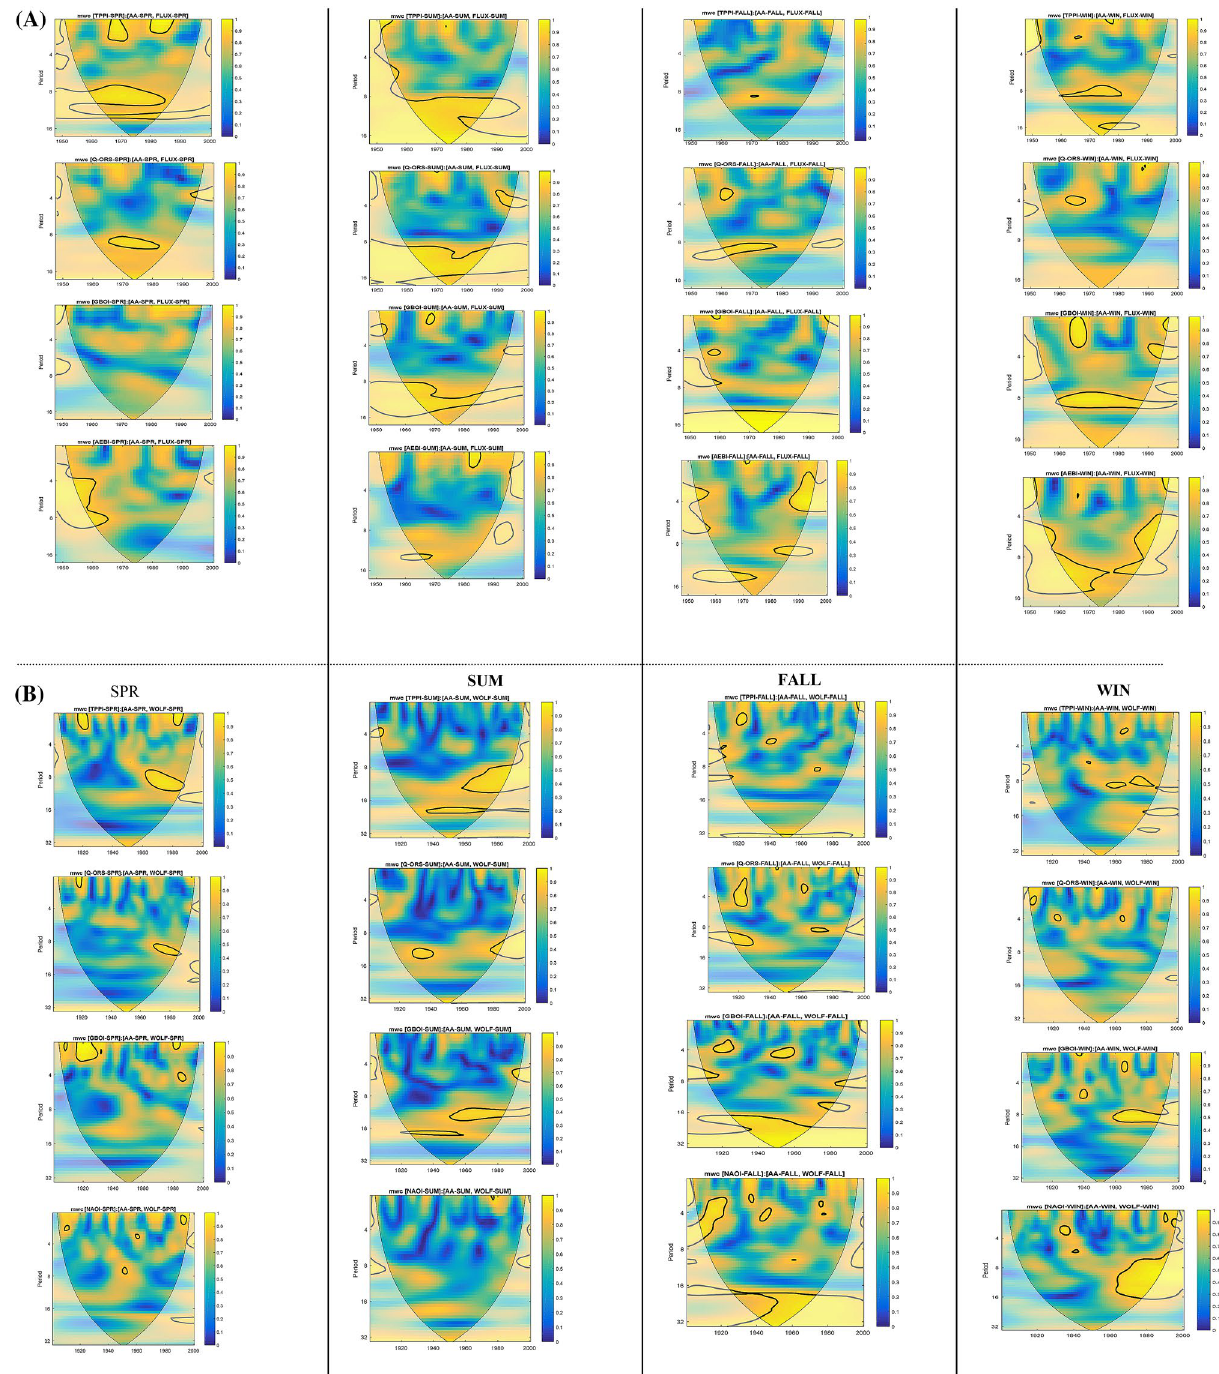
Figure 2. ( A ) Multiple wavelet coherence (MWC) between aa and solar flux for Period I. ( B ) Multiple wavelet coherence (MWC) between aa and Wolf number for Period